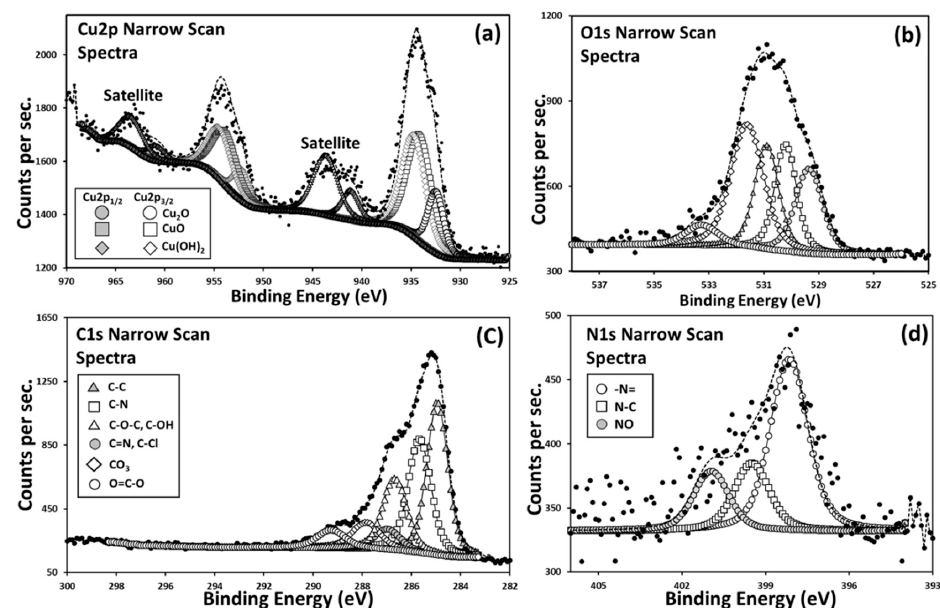
Figure 3. XPS narrow spectra of PVC/pDA/Cu disc surface; ( a ) Cu2p, ( b ) O1s, ( c ) C1s and ( d ) N1s. References to individual peak assignments are shown in supporting information table SI-T1.